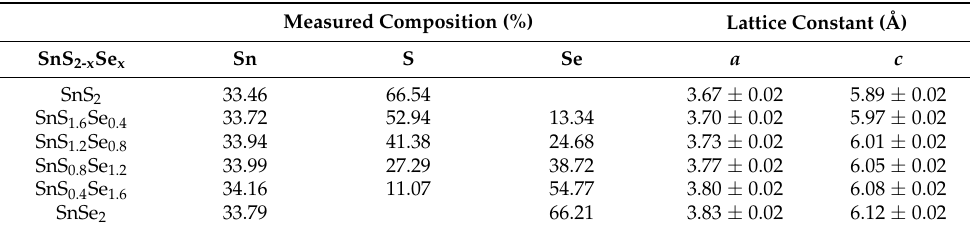
Table 1. The composition x of the SnS 2-x Se x alloys assessed by electron probe X-ray micro-analyzer (EPMA) and lattice constants a and c deduced from HRTEM and XRD, respectively.